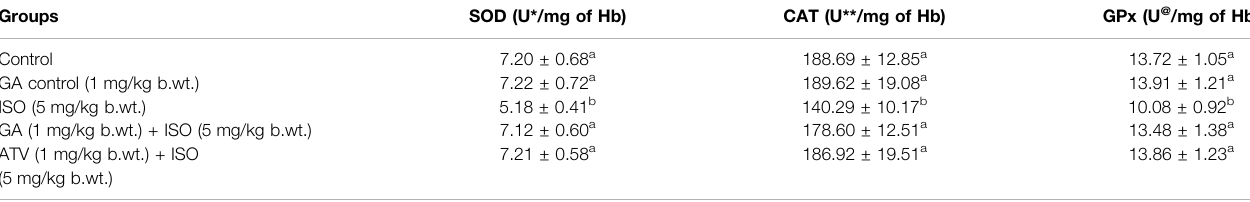
TABLE 4 | Effect of GA on the activities of SOD, CAT and GPx in the erythrocytes of control and ISO-induced rats. Groups SOD (U*/mg of Hb)